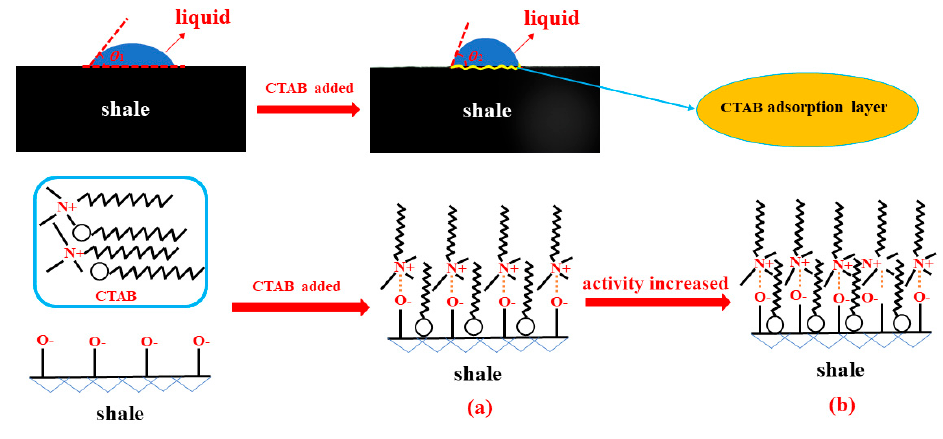
Figure 5. The adsorption mechanism of CTAB on the surface of Figure 4. The adsorption mechanism of CTAB on the surface of shale.